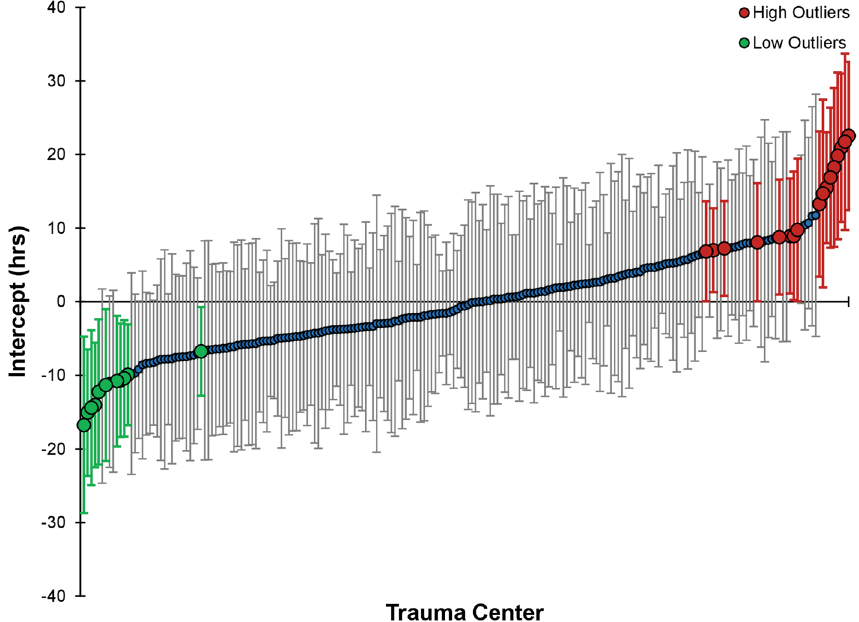
Figure 2. ‘Caterpillar plot’ of trauma center MDs and 95% CIs for time to surgical decompression, risk-adjusted for patient- and hospital-level characteristics 45 .